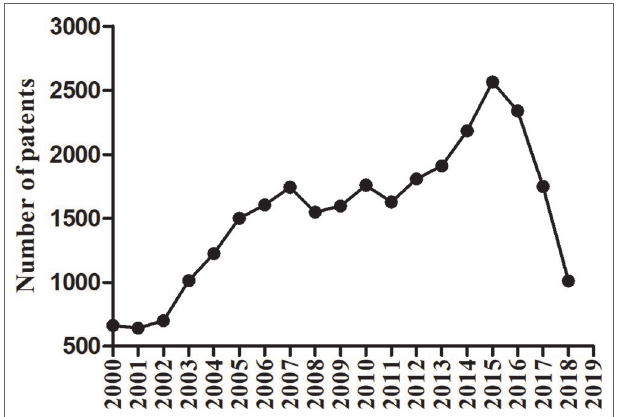
FIGURE 2 | Trend analysis on the population of patents with diabetes mellitus in China.